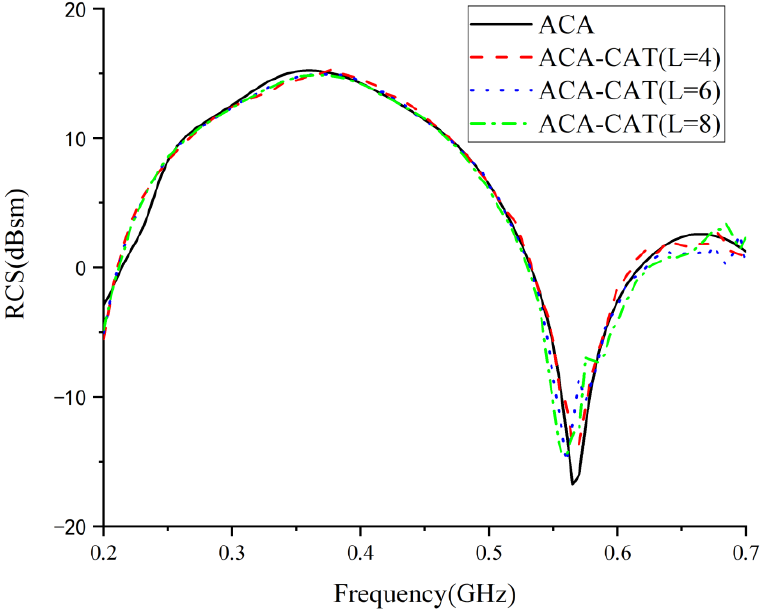
Figure 5. Broadband BCS of a four-patch array computed by ACA-CAT for three different orders.